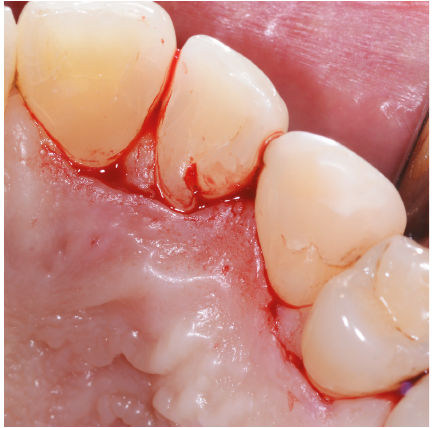
Figure 3: A horizontal incision on the palatal aspect was performed, preserving the interdental